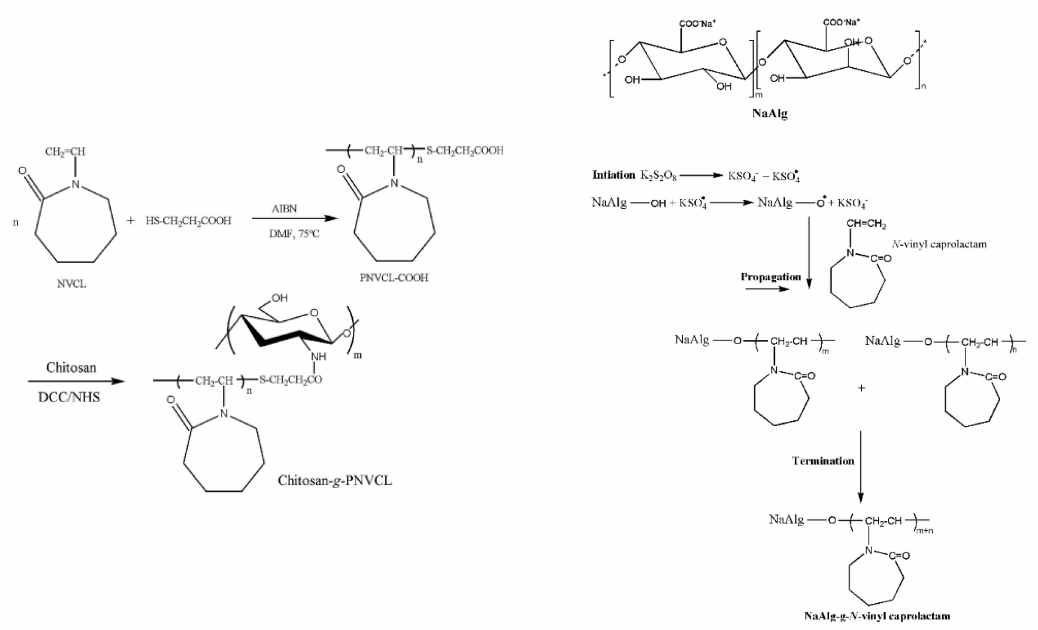
Figure 3. Synthesis of the graft copolymers of CS and SAlg with NVCL [75,77]. (Reproduced